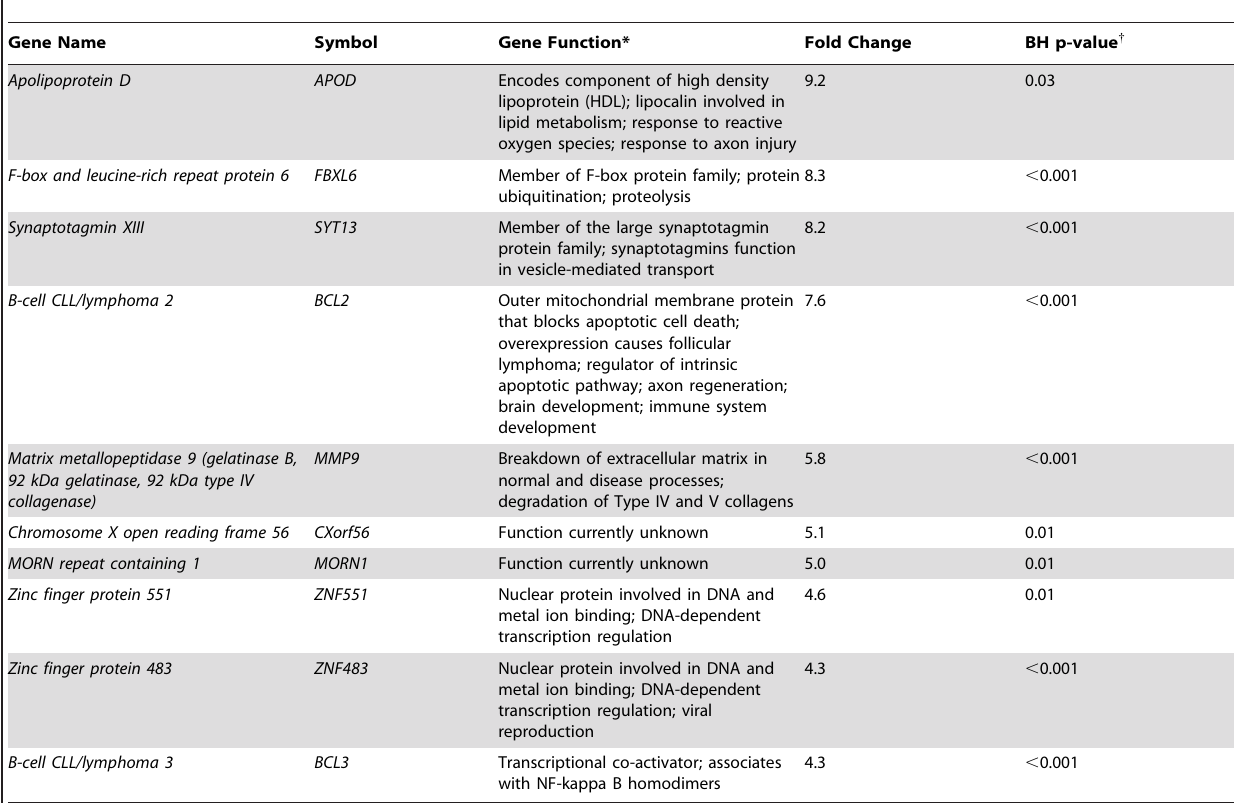
Table 3. Top ten most up-regulated genes in fetuses of obese versus lean women in the second trimester.